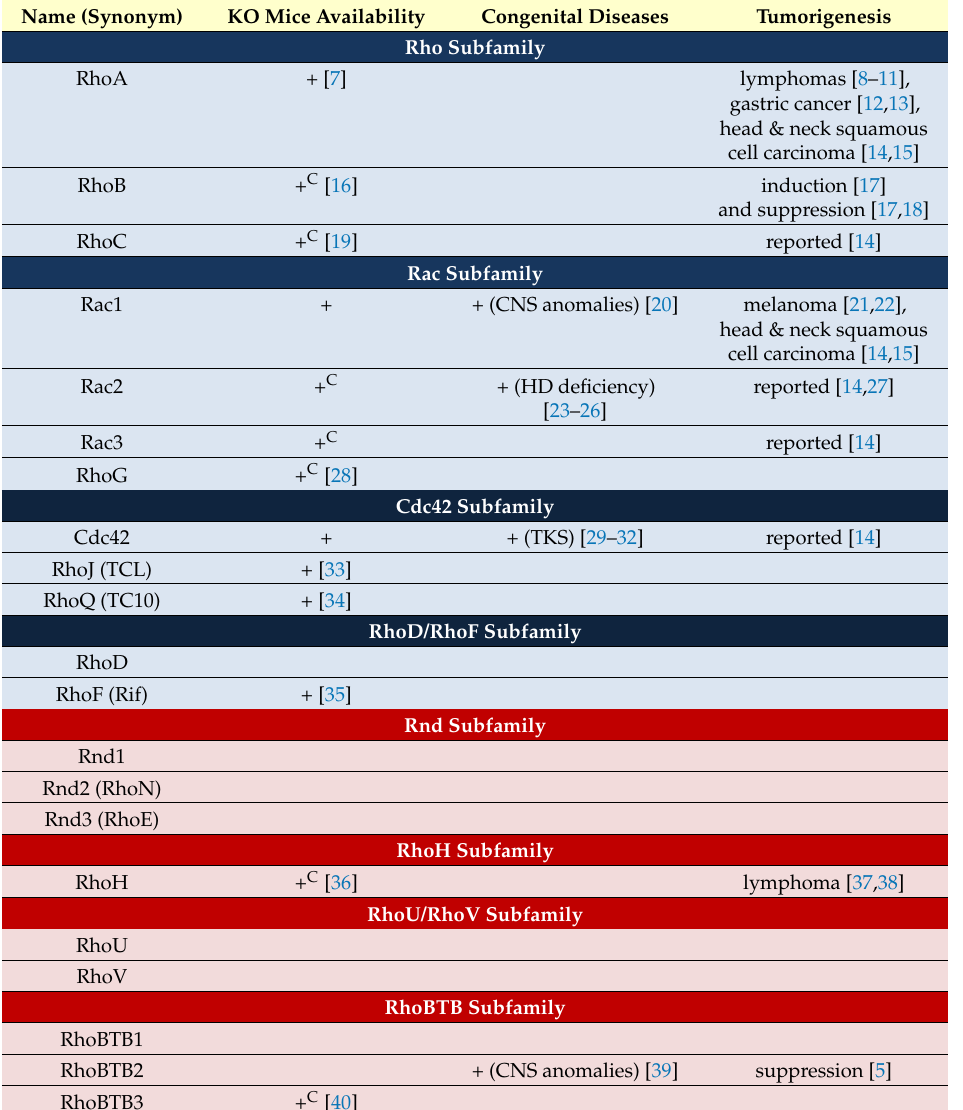
Table 1. Knockout (KO) mice availability, congenital diseases, and tumorigenesis-associated Rho-family GTPases. Blue indicates typical (classical) Rho-family GTPases including the Rho, Rac, Cdc42, and RhoD/RhoF subfamilies. Red indicates atypical Rho-family GTPases including the Rnd, RhoH, RhoU/RhoV, and RhoBTB subfamilies. CNS: central nervous system, HD: host defenses, TKS: Takenouchi-Kosaki syndrome. +: conditional floxed mice. + C : conventional KO